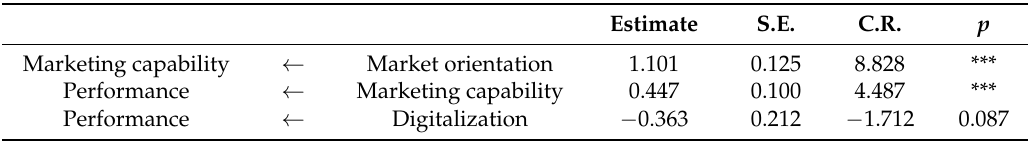
Table 3. Estimated values, standard errors (S.E.) critical ratios (C.R.) and probability values ( p ) for the path model (internationalized firms).